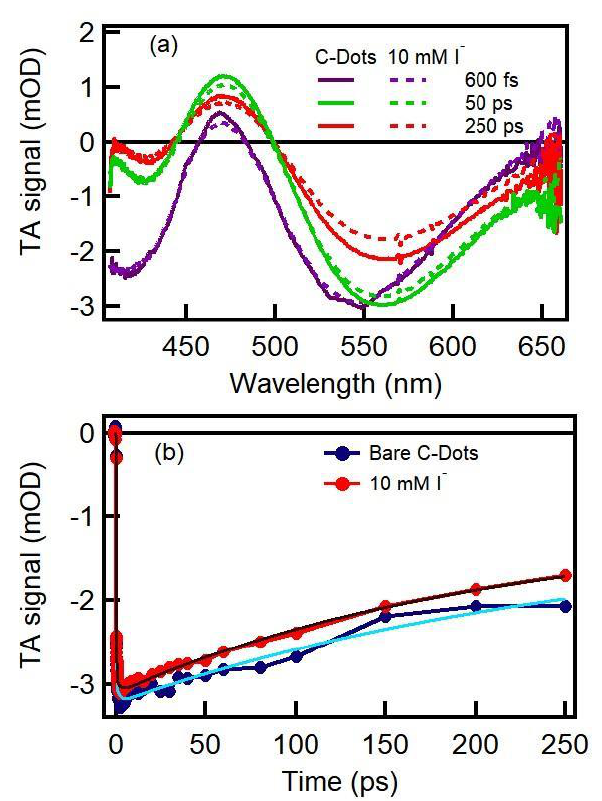
Figure 5. ( a ) Normalized transient absorption spectra of a solution of bare C-dots (continuous lines) and of a solution of C-dots with 10 mM iodide ions (dashed lines), recorded at 600 fs (purple lines), 50 ps (green lines) and 250 ps (red lines) delays after photo-excitation at 400 nm. ( b ) Kinetic traces at 550 nm (peak of stimulated emission), extracted from the data in panel a for bare C-dots (blue lines) and C-dots with 10 mM of iodide (red line), respectively, and their best fitting curves.